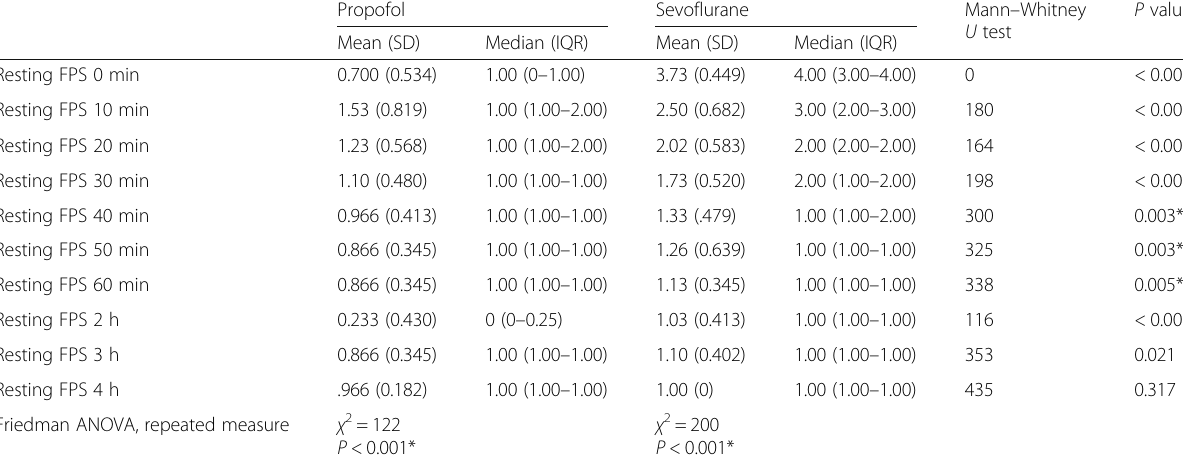
Table 3 Postoperative resting face pain score during the 4-h postoperative period Propofol